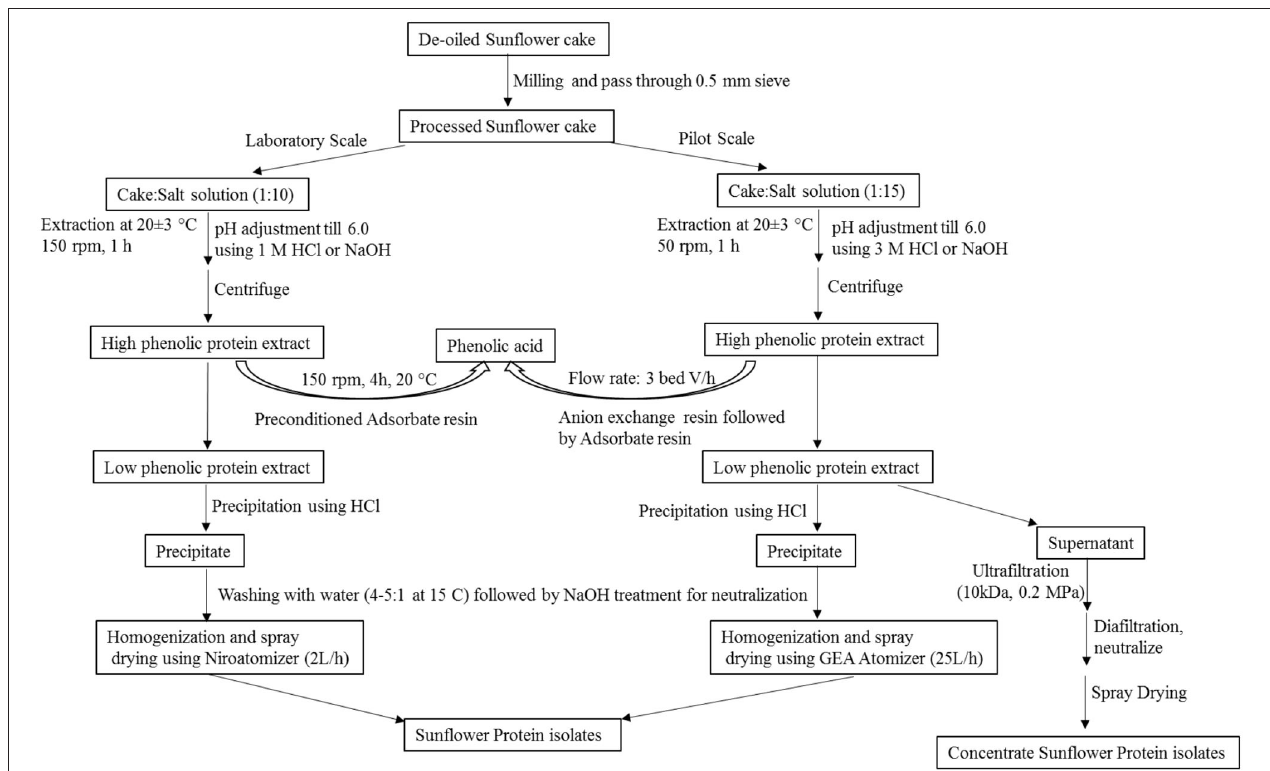
FIGURE 4 | Schematic process for extraction of protein isolates and concentrates from de-oiled sunflower cake.